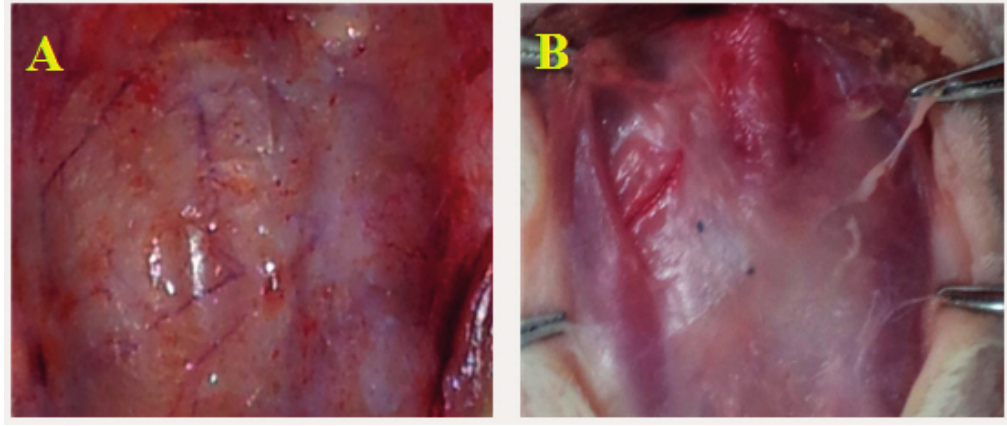
Figure 1. Macro-observation of bacterial cellulose (BC) after implantation. ( A ) Day 30, connective tissues covered the BC also on the unpatched side. No cerebrospinal fluid (CSF) leakage, abscess, congestion or edema was observed on the surface of brain; and ( B ) Day 360, periosteal new bone formation. BC and new bone were difficult to separate and had blended with the surrounding